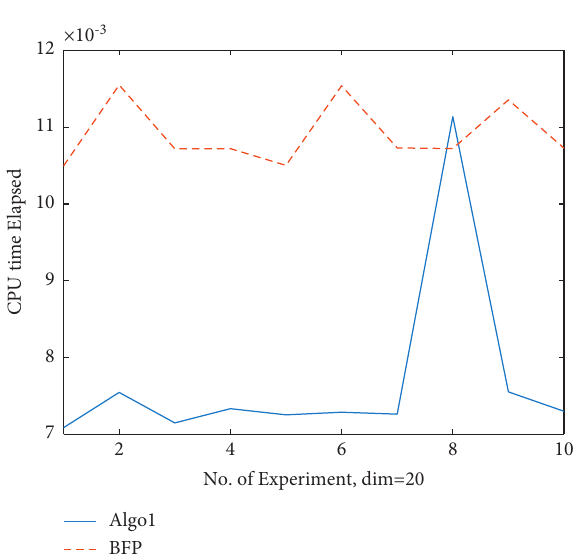
Figure 17: CPU time vs no. of iteration for dimension